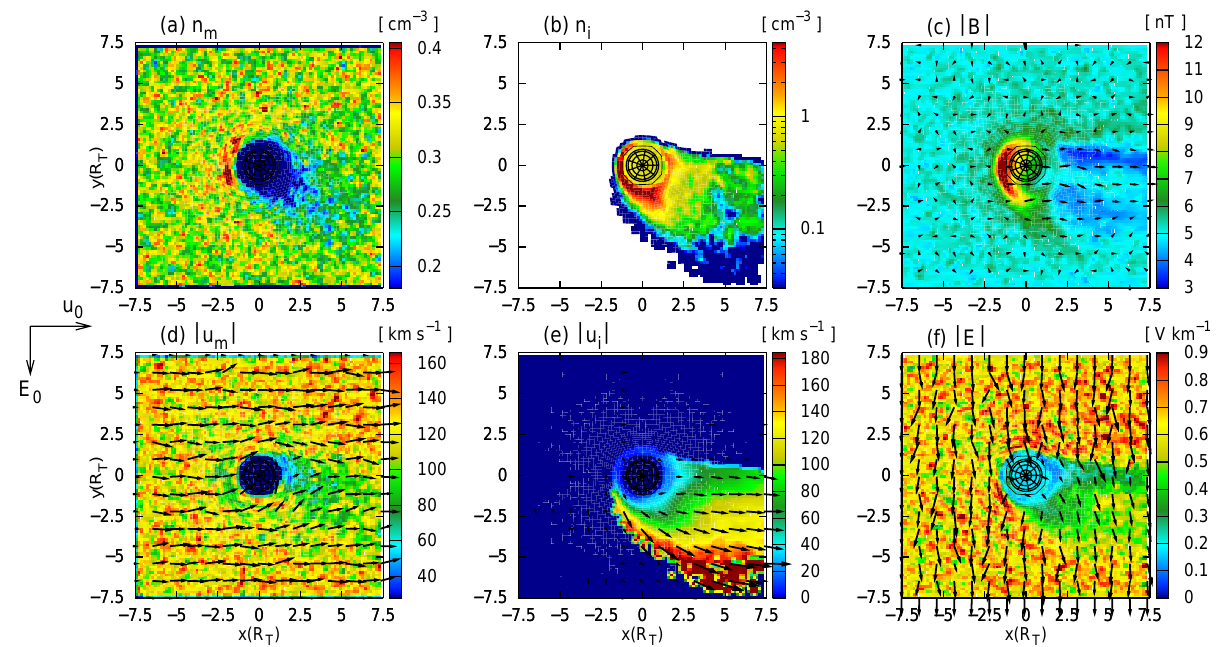
Fig. 11. Interaction between Titan’s ionosphere and the subsonic Saturnian magnetospheric plasma flow at 18:00 local time. The figure displays a cut through Titan’s equatorial plane. The undisturbed plasma flow is directed in ( + x) direction, whereas the convective electric field E 0 is orientated antiparallel to the z axis. In analogy to the case of supersonic flow, the structure of the interaction region exhibits a strong asymmetry between both hemispheres. The convective electric field, being antiparallel to the y axis, forbids the ionospheric tail to expand into the E − hemisphere. On the other hand, the electric force drags the ions away from the obstacle in the E + hemisphere, resulting in the formation of an extended pick-up region. However, in the E − hemisphere, the increase of ionospheric density at the outer flank of the tail is not as sharp as in the case of supersonic flow. Due to the resulting electron pressure gradient being significantly weaker than in the supersonic case, the magnetospheric ions are no longer prevented from entering the tail region and mixing with the ionospheric plasma. For this reason, only a slight, but still asymmetric decrease of magnetospheric plasma density occurs downstream of the obstacle. In regions where the ionospheric ion velocity is low, an area of reduced electric field strength is formed. On the other hand, in the E + hemisphere the ionospheric velocity is comparable to the ambient plasma velocity and hence, these ions are able to make a significant contribution to the convective electric field. For this reason, the reduction of electric field strength diminishes in regions where the ionospheric particles are accelerated due to the pick-up